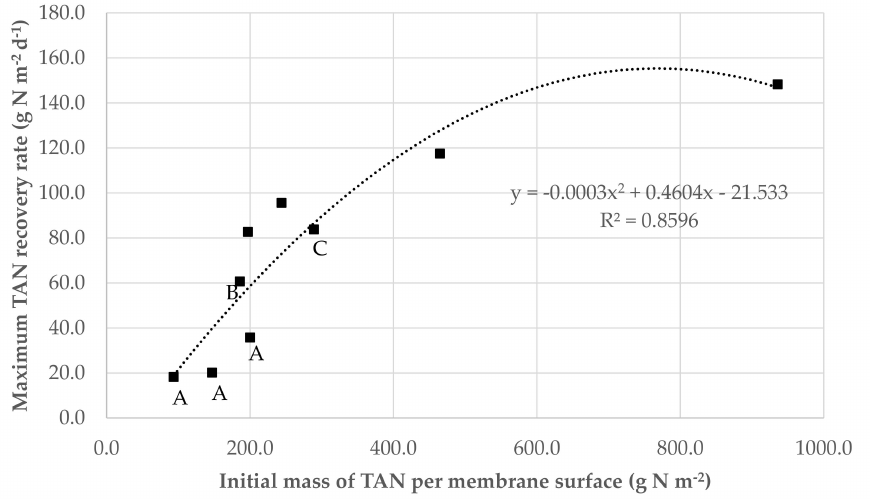
Figure 3. Maximum recovery rates in the literature studies and in the present study using GPM technology for N recovery vs. the ratio of initial mass of TAN in wastewater per membrane surface. A second order equation and R 2 are represented: (A) Garc í a-Gonz á lez and Vanotti [15]; (B) Garc í a- Gonz á lez et al. [14]; (C) Garc í a-Gonz á lez et al. [24]. Values of the present study are presented as symbols without